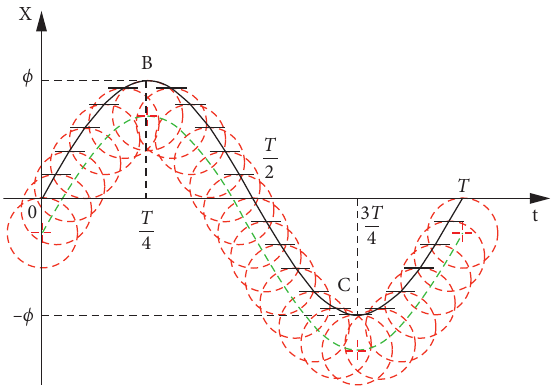
Figure 6: Running track diagram of the slip ring in one